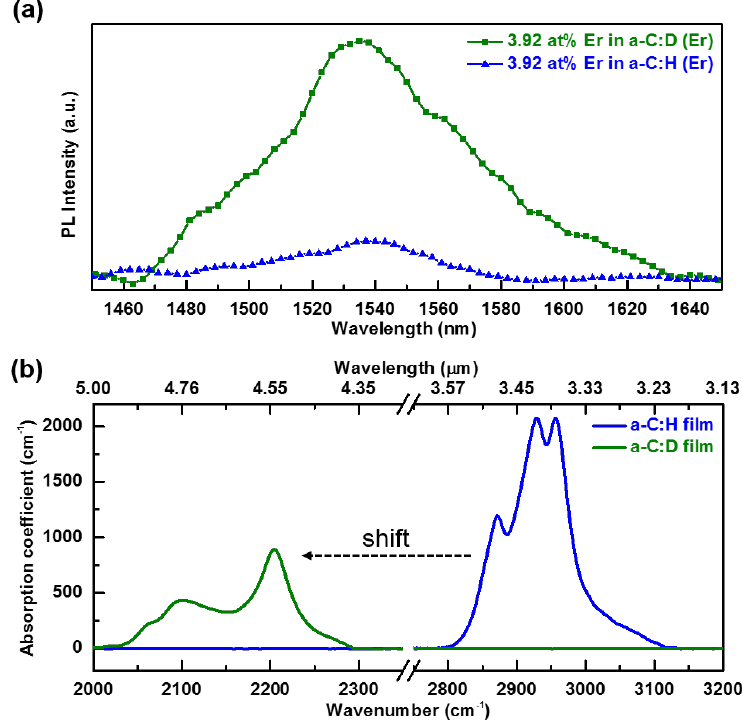
Figure 1. ( a ) Comparison of PL intensity of a-C:D(Er: 3.92 at% ) and a-C:H(Er: 3.92 at %)